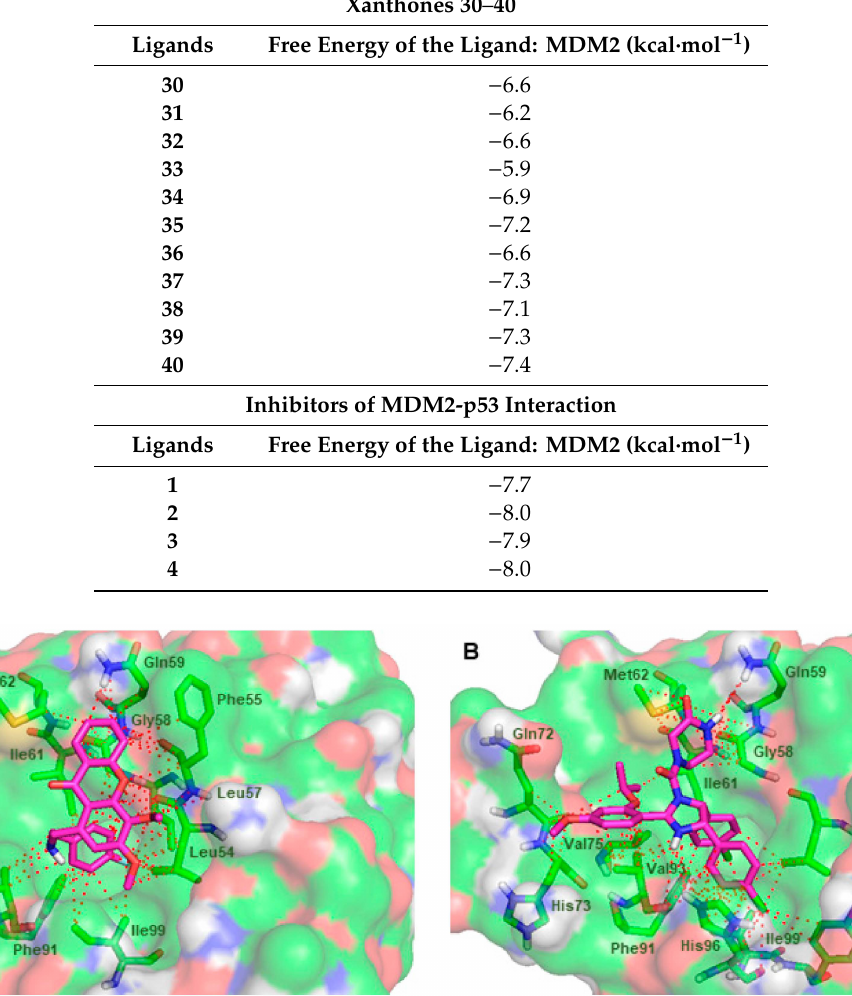
Figure 6. ( A ) Predicted binding pose of the xanthone 37 (purple sticks) in the binding site of MDM2. ( B )MDM2(transparentsurface)incomplexwiththecrystallographicnutlin-3A( 1 , purplesticks). MDM2 is represented as a transparent surface, where carbon, oxygen, nitrogen, and sulfur are represented in green, red, blue, and yellow, respectively. Small molecule-MDM2 interactions are depicted with a dashed red line. MDM2 residues involved in interactions with the ligands are represented as green sticks and